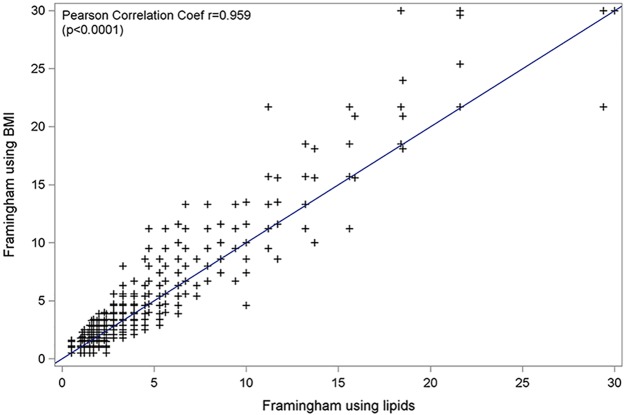
Agreement between the Framingham equations using lipids and BMI; Temprano trial (N = 1422).